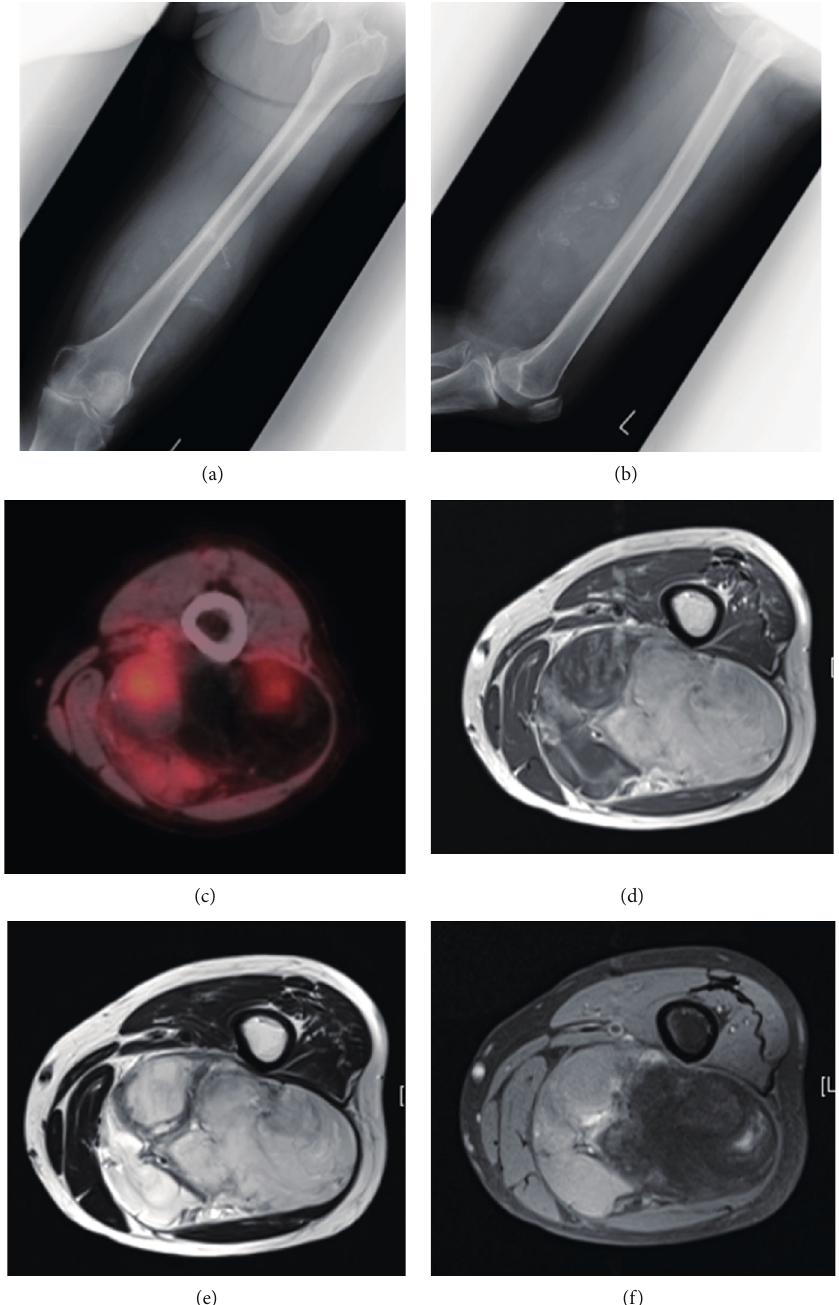
Figure 1: Images of myxoid liposarcoma in the left thigh at initial visit. Plain radiograph in (a) anteroposterior and (b) lateral view, (c) PET, (d) T1-weighted, (e) T2-weighted, and (f) T1-weighted fat suppressed